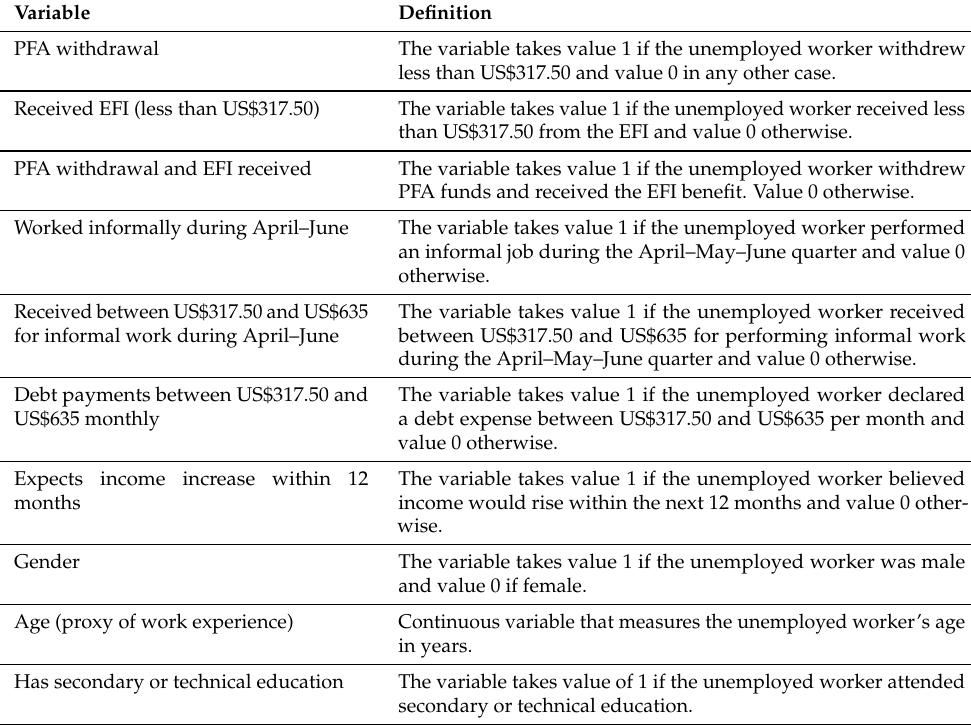
Table 1. Definition of variables considered in the